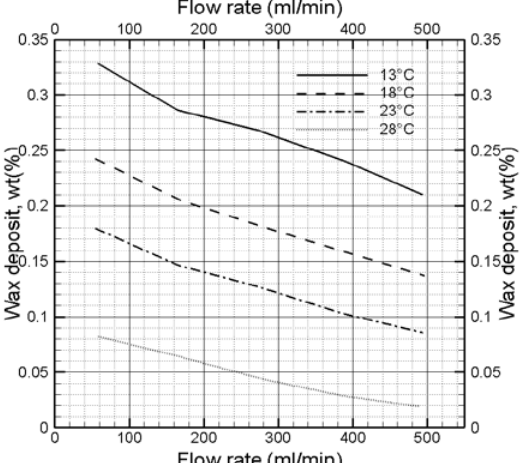
Figure 10 Effect of flow rate on deposited wax percentage at 6 min (Kelechukwu et al., 2010)